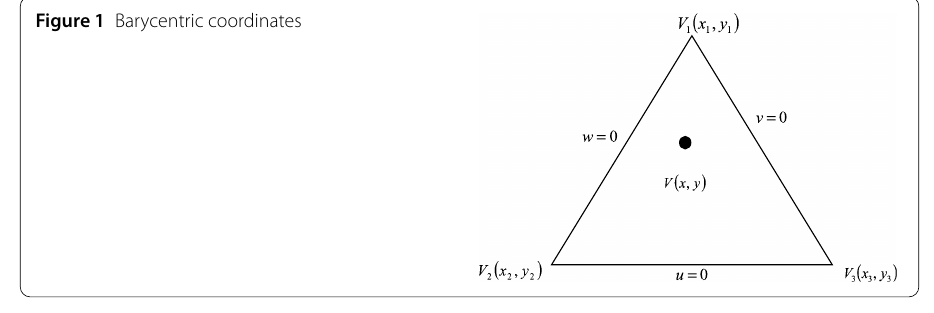
Figure 1 Barycentric